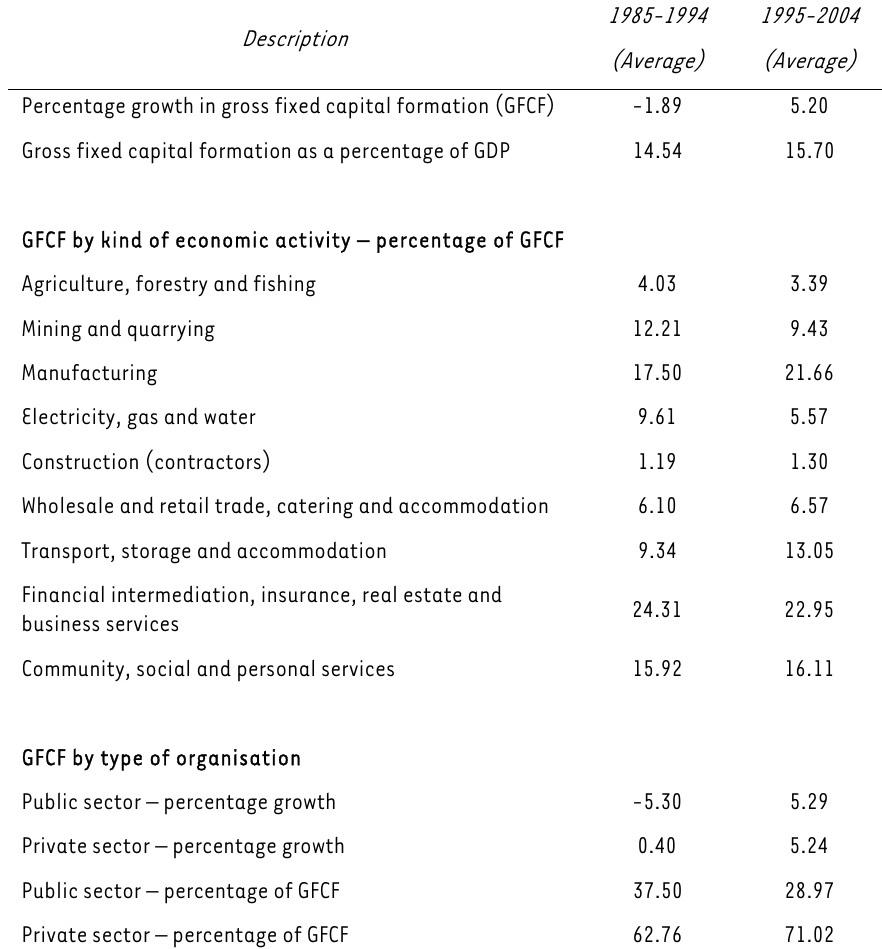
TABLE 2: Fixed capital formation growth and composition